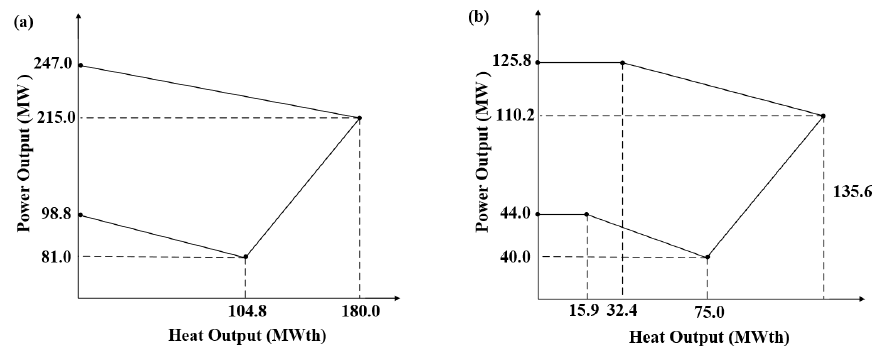
Figure 4. Feasible operation region of two cogeneration plants. ( a ) cogeneration unit 2 and ( b ) cogeneration unit 3. Table 1. Characteristic parameters of test system I.